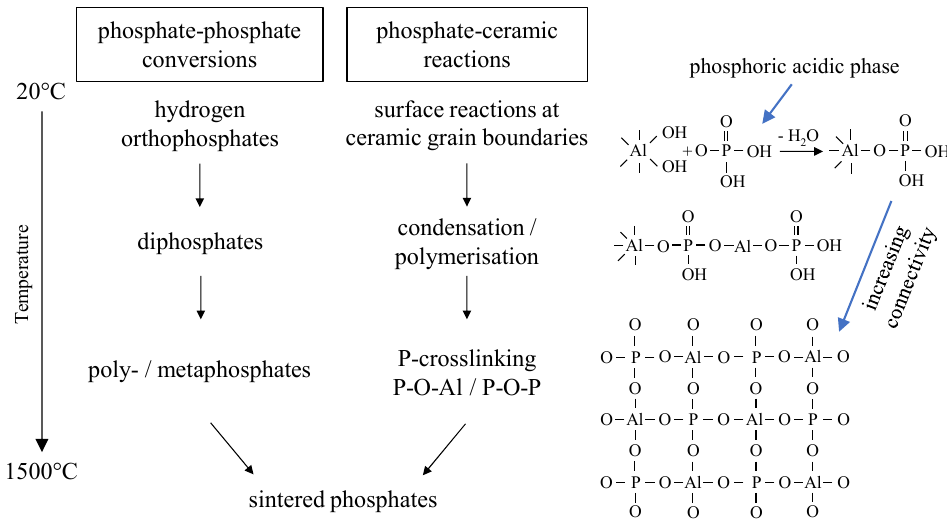
Figure 1. Overview of the bonding mechanism of inorganic phosphate binders in an alumina-based ceramic application as a function of temperature.